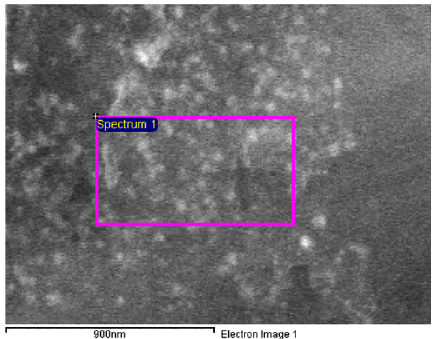
Figure 4. SEM analysis of Silver Nanoparticle of